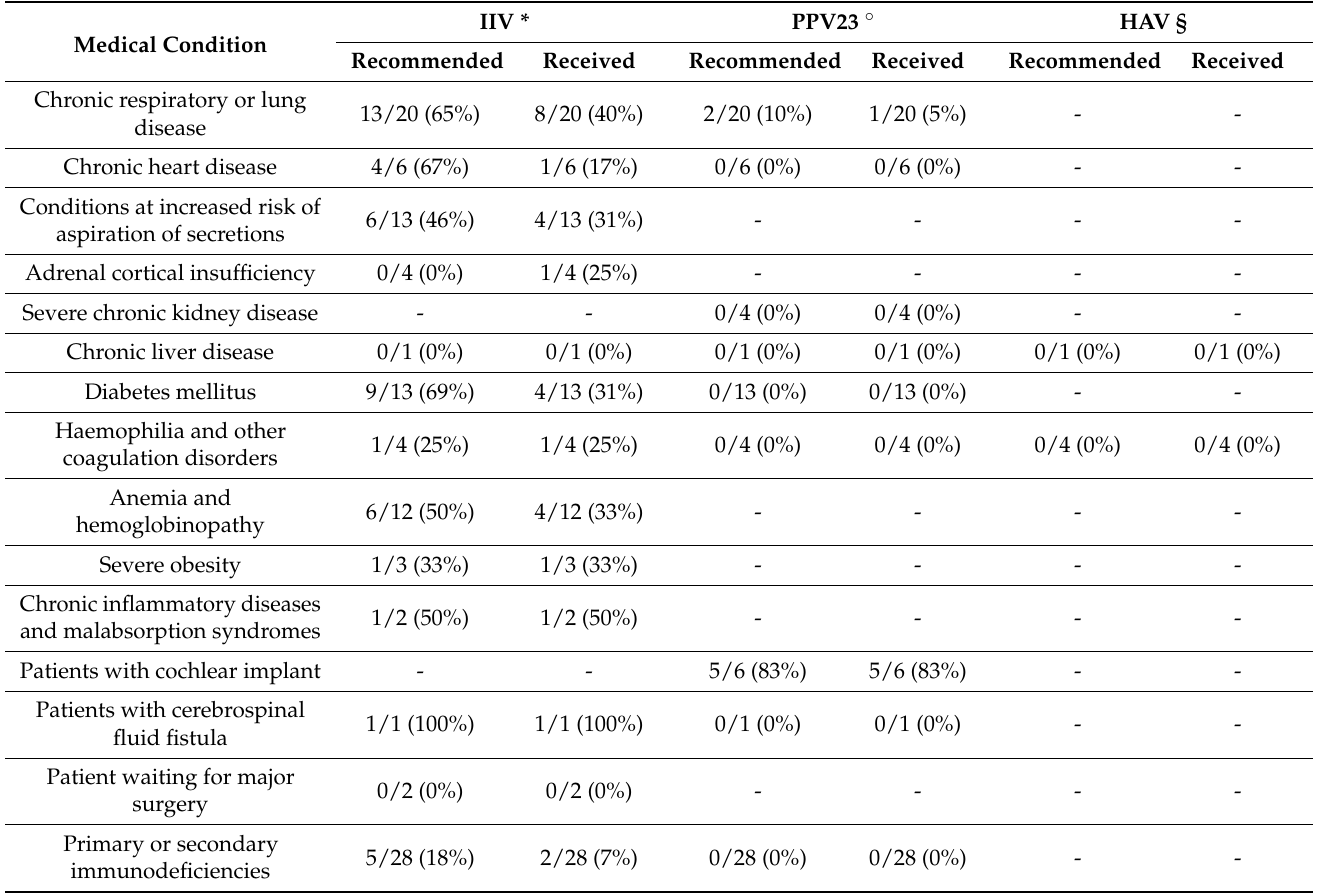
Table 4. Percentage of additional vaccinations recommended and actually administered by medical condition. In case a child was diagnosed with more than one chronic condition, responses were included in the analysis of each